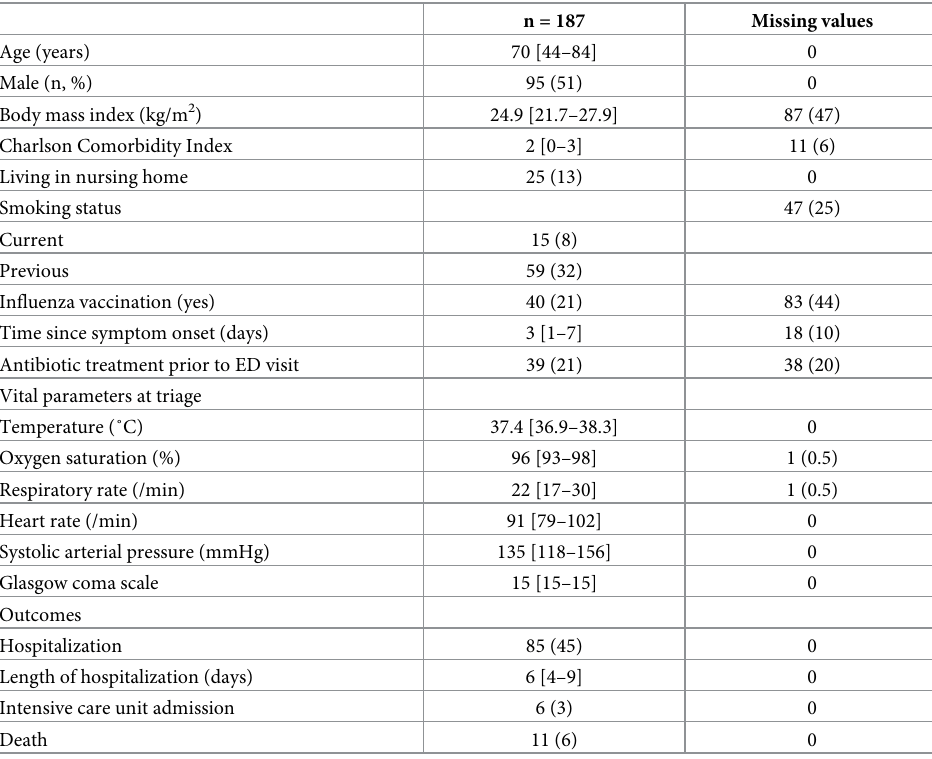
Table 1. Patient characteristics.